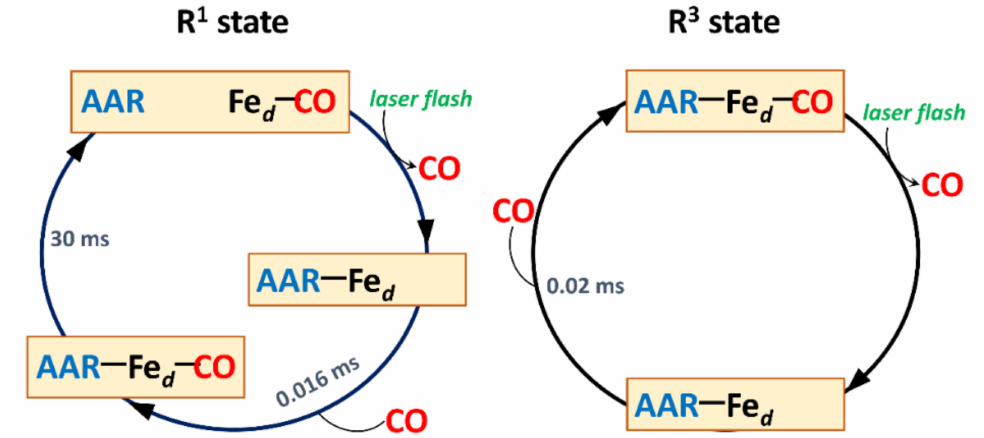
Figure 6. Proposed scheme for a cycle of photolysis and recombination of CO to bd -type oxidase in one-electron-reduced (R 1 ) and fully reduced (R 3 ) states. In the R 1 state, photodissociation of CO from the ferrous heme d iron (Fe d ) is accompanied by binding of the axial ligand, an amino acid residue (AAR), at the opposite side of the heme. CO rebinds to Fe d with τ of 0.016 ms producing a transient hexacoordinate state (AAR–Fe d –CO). Then AAR is dissociated from Fe d with τ of 30 ms. In the R 3 state, AAR is a permanent indissociable ligand to Fe d . Photodissociation of CO from Fe d is followed by its rebinding to the heme with τ of 0.02 ms. AAR is either H19 [34] or E99 [35]. The scheme is based on time-resolved spectroscopic studies [47–49]. The electron transfer in the opposite direction (back-flow) observed in the R 1 state occurs to a much lesser extent than in heme-copper oxidases and therefore is not shown in the